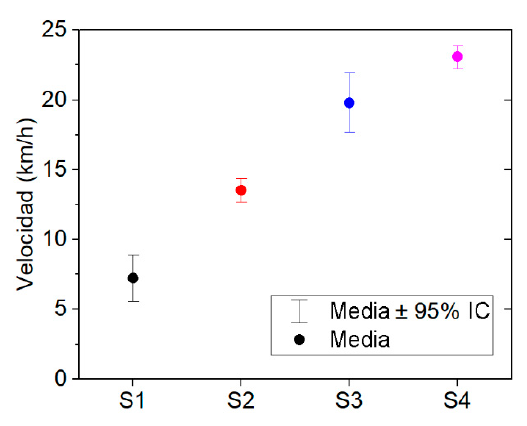
Figure 2. Mean speed of displacement according to type of surface.